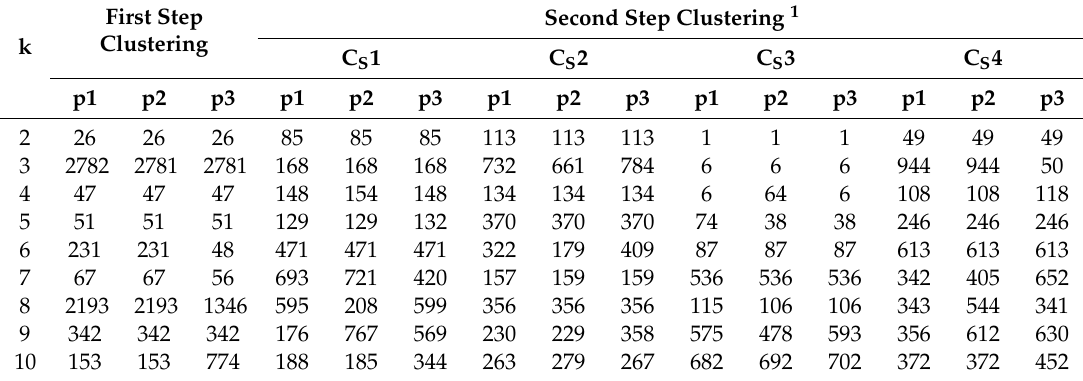
Table 1. Experimental results of clustering stability based on minimal matching distance.